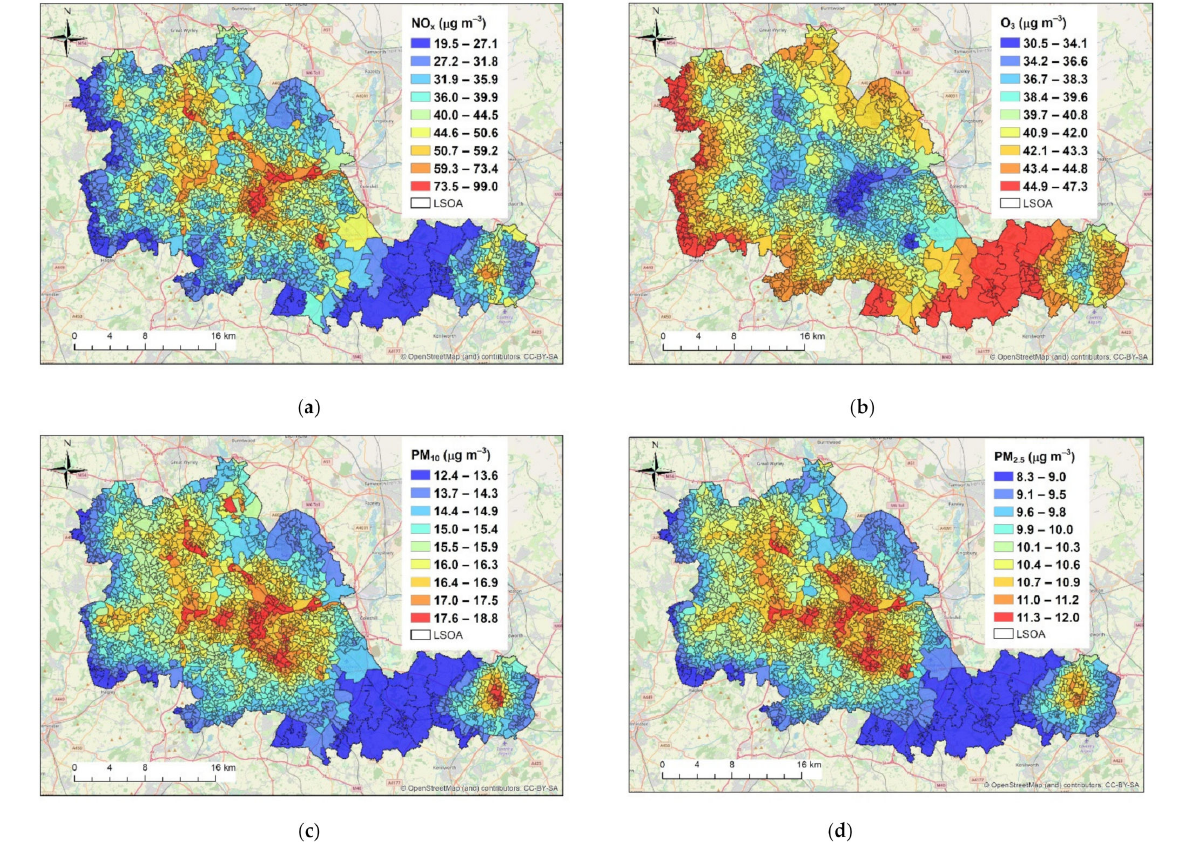
Figure A2. Projected annual air quality maps for ( a ) NO x (in µ g m − 3 ), ( b ) O 3 (in µ g m − 3 ), ( c ) PM 10 (in µ g m − 3 ) and ( d )